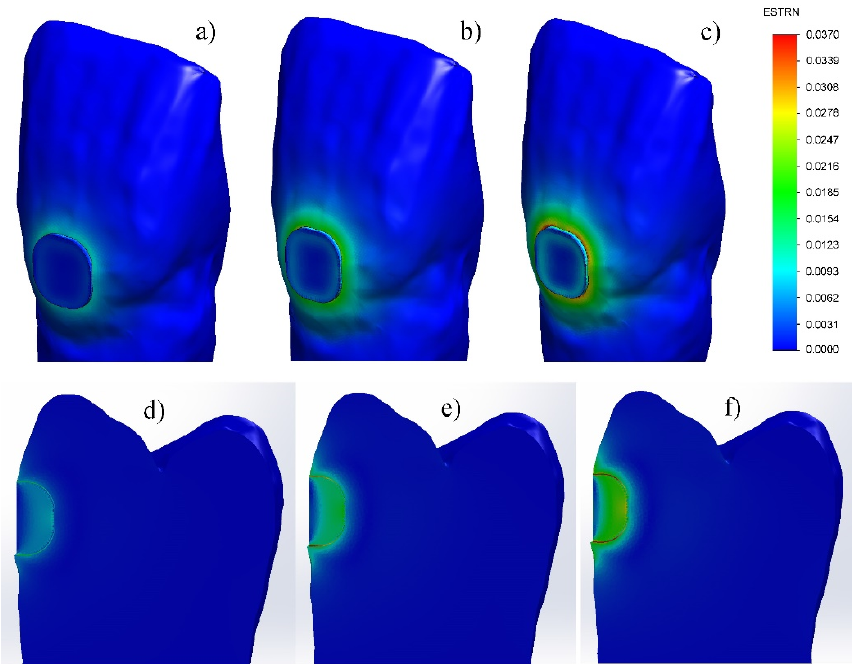
Figure 5. Strain during setting process of fillings made with: (a), (b), (c) glass-ionomer cement; (d), (e), (f) flowable photo-cured composite. (1% shrinkage—(a), (d); 2% shrinkage—(b), (e); 3% shrinkage— (c), (f)).